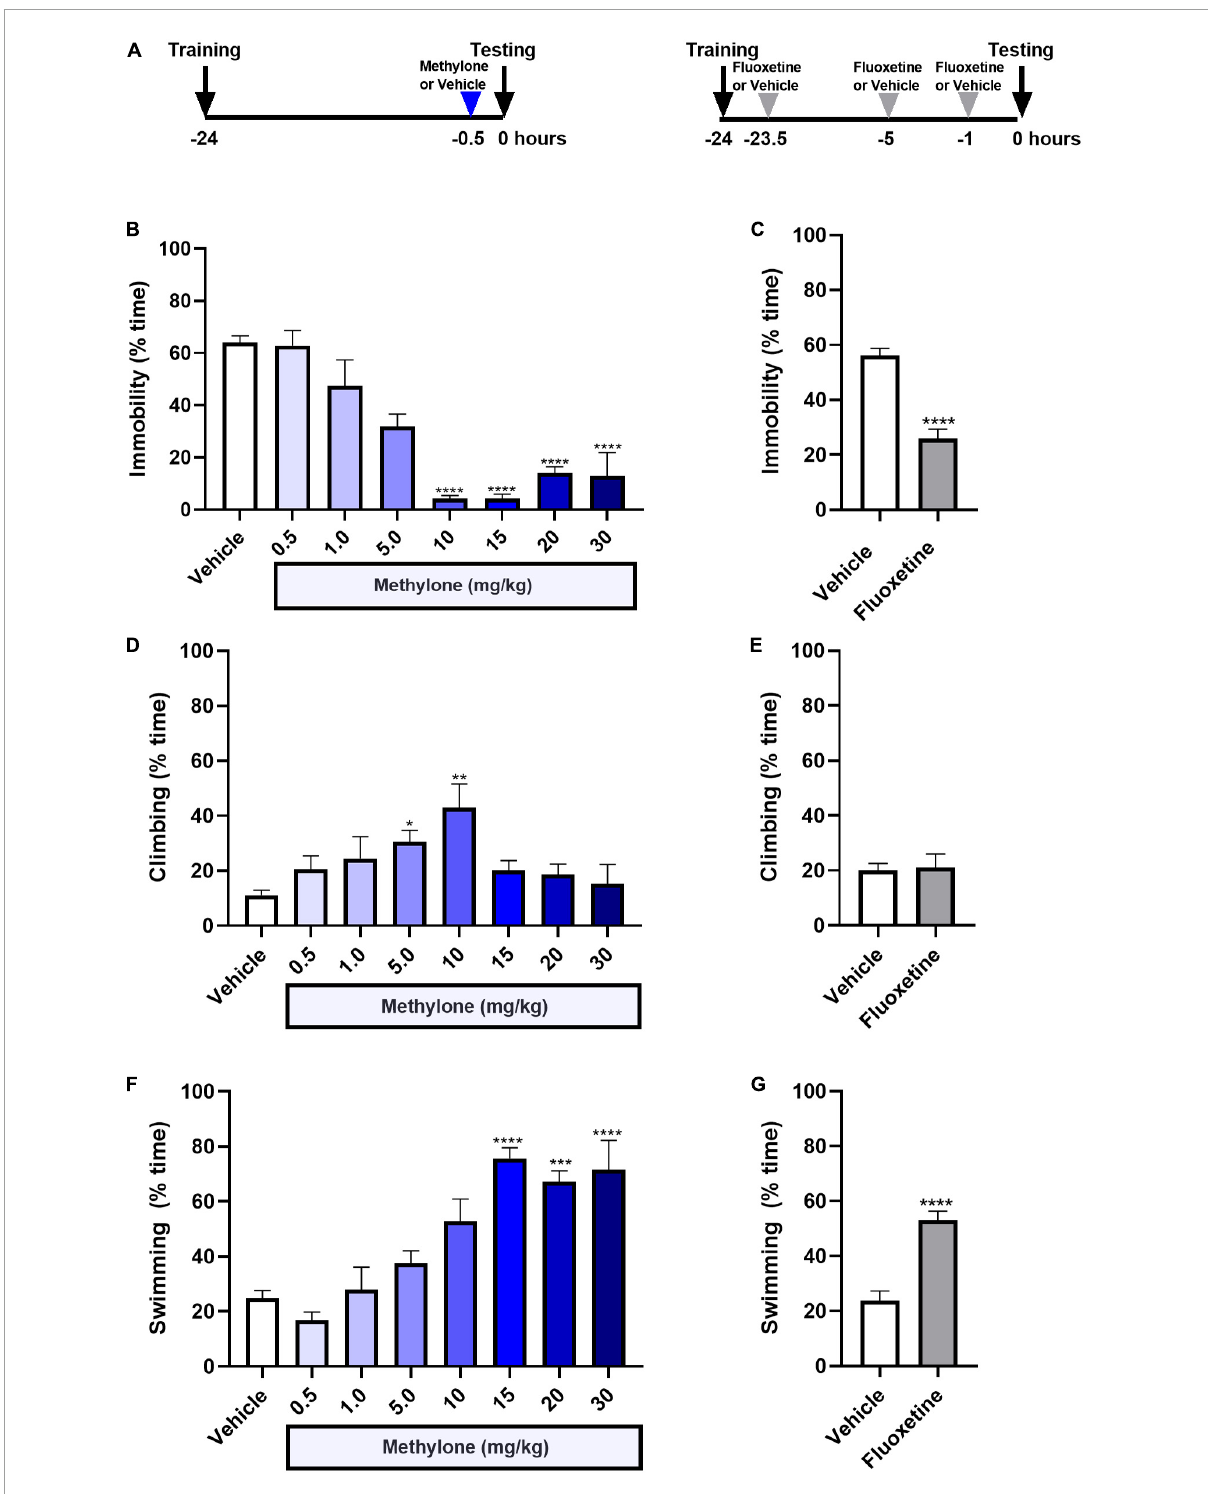
FIGURE1 Methylone has a rapid-acting and robust antidepressant-like response in the forced swim test. (A) Schematic shows experimental design. Methylone (0.5–30 mg/kg, IP) or saline (Vehicle) was administered 30 min prior to testing. Fluoxetine (10 mg/kg, IP) or saline (Vehicle) were administered 23.5, 5, and 1 h prior to testing. Quantification of the percent time spent (B,C) immobile, (D,E) climbing, or (F,G) swimming during the 5-min test session is shown. Data are presented as means ± SEM. * p < 0.05, ** p < 0.01, *** p < 0.001, **** p < 0.0001 vs. Vehicle control group, Bonferroni’s post-hoc test; N = 6–16 per